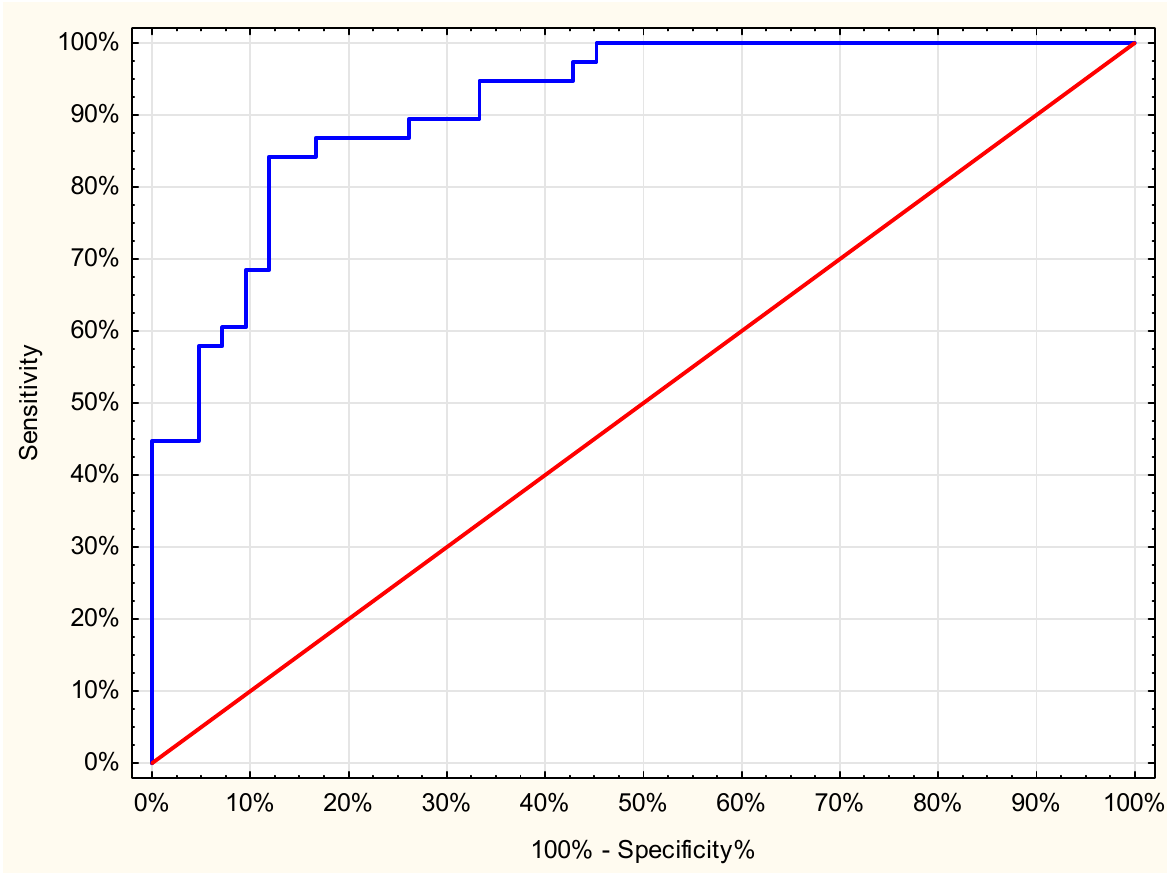
Figure 4. Receiver operating characteristic curve; The receiver operating characteristic curve of the persistent pain model was calculated with logistic regression.